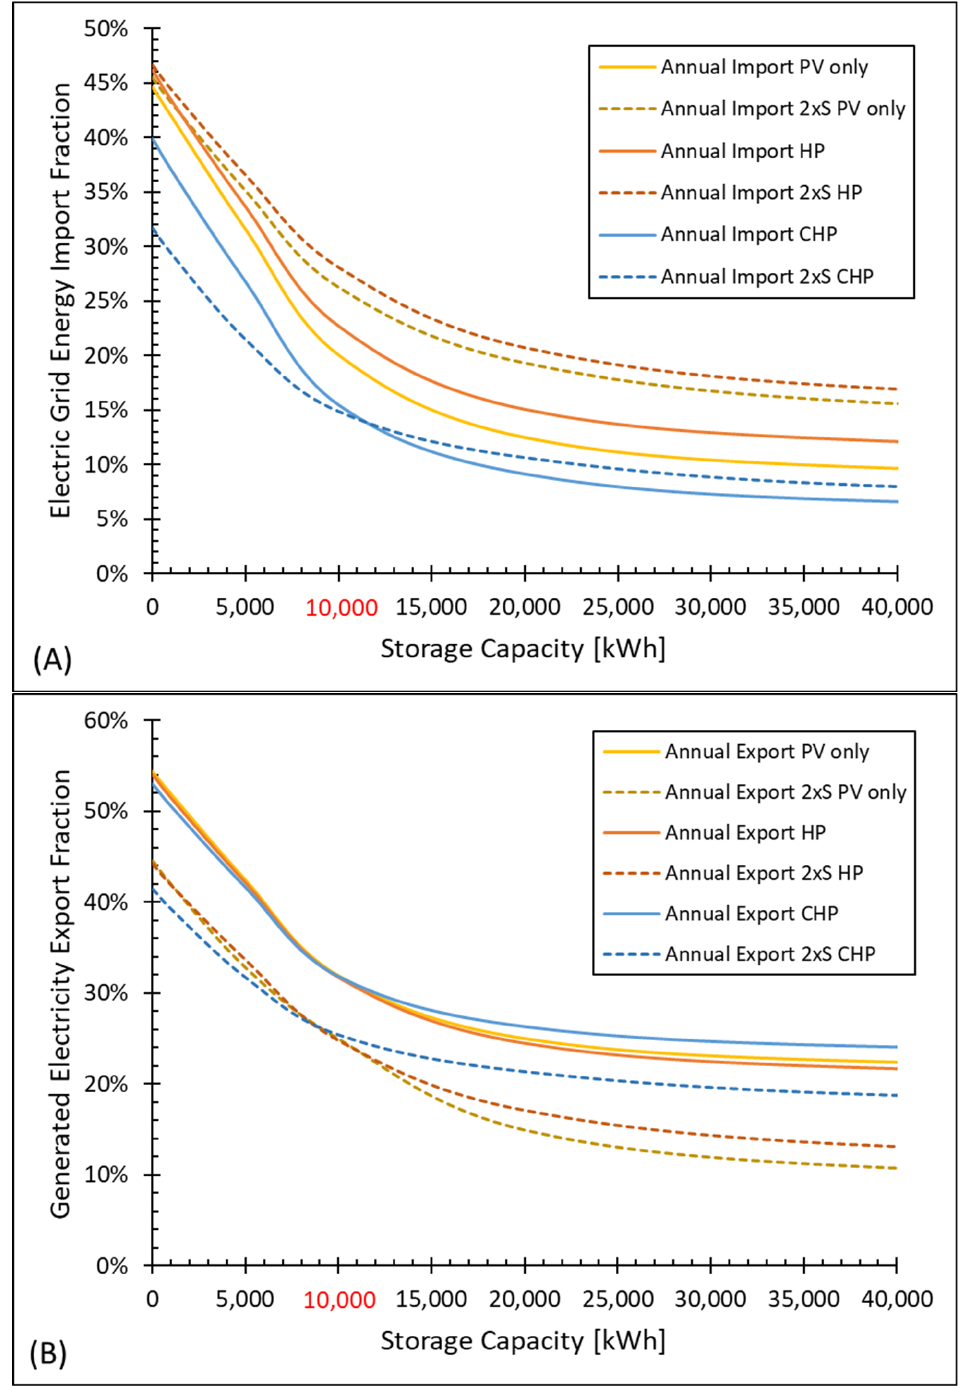
Figure 5. Effect of storage capacity. Plot ( A ) displays the imported grid electricity as a fraction of total electric load. The CHP scenarios import the smallest fraction of electricity while the 2 × Summer (2 × S) load scenarios generally increase the fraction of imported electricity. Plot ( B ) displays the exported electricity as fraction of total generation. The 2 × S scenarios reduce export fraction most significantly due to alignment of peak summer load and peak PV generation. Increased storage reduces import and export fractions in all scenarios, with an effect that is greatest at smaller storage capacities. A levelized cost optimal 10,000 kWh of storage was assumed in the